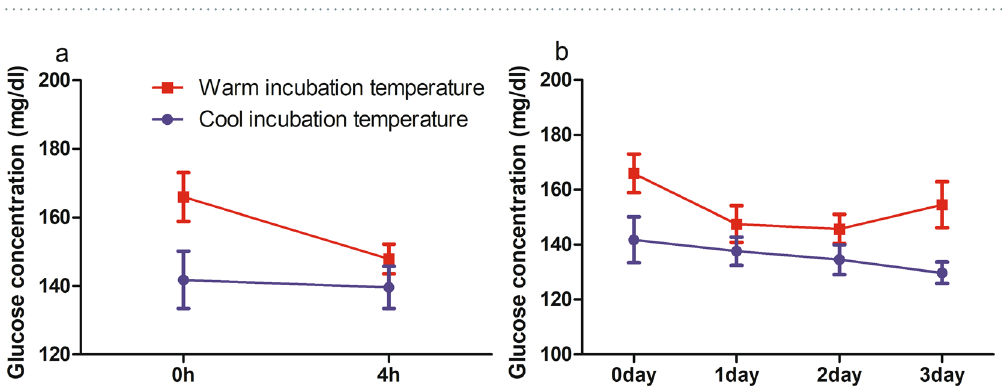
Figure 3. The effect of incubation temperature on blood glucose concentration of loggerhead sea turtles from ( a ) 0 h to 4 h and ( b ) 0 d to 3 d (72 h) (n = 7–8 at each sampling point for each IT group). Results are expressed as mean ±